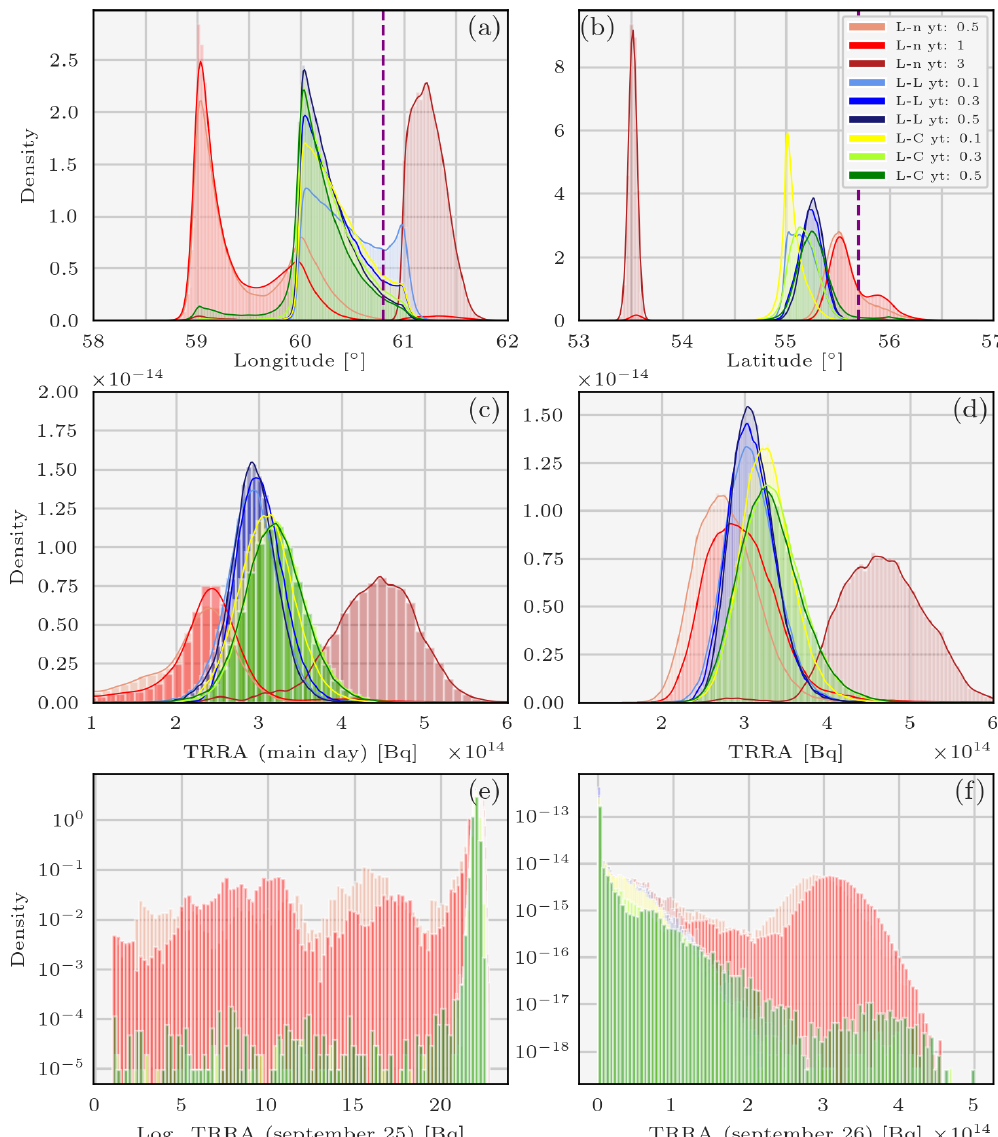
Figure 7. Pdfs of the variables describing the 106 Ru source sampled using the parallel tempering method and the enhanced ensemble of observation operators and the observation-sorting algorithm and for various likelihoods: longitude (a) , latitude (b) , TRRA on the main day (c) , TRRA (d) , log. TRRA on 25 September (e) and TRRA on 26 September (f) . L-L means log-Laplace, L-n means log-normal, L-C means log-Cauchy, and y t is the likelihood